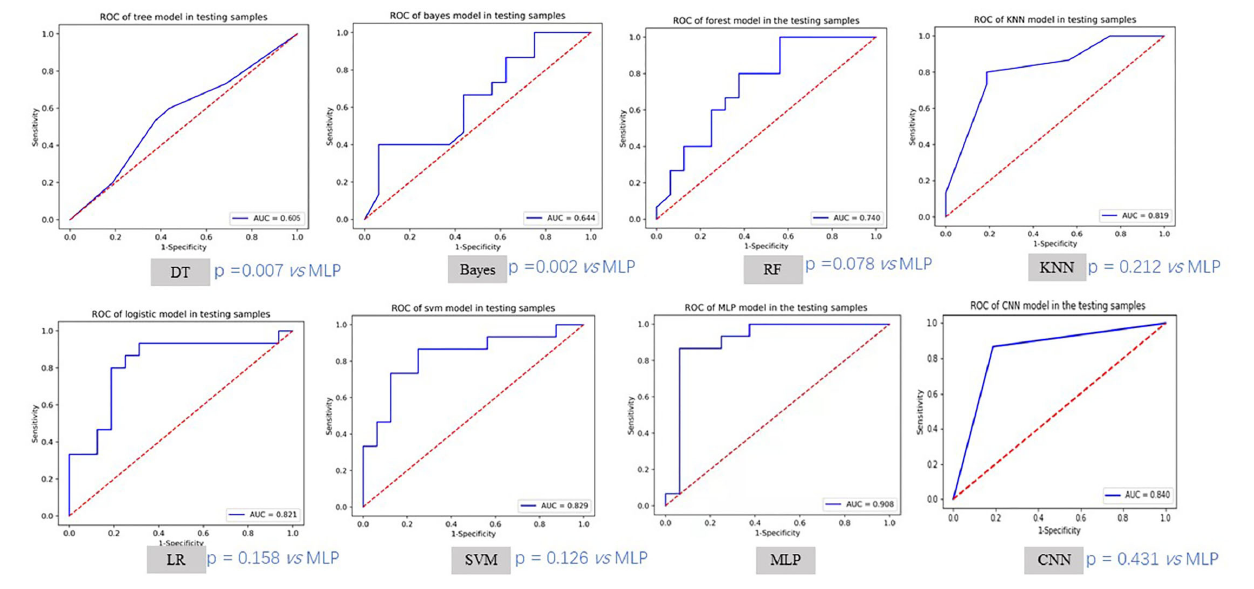
in identifying the two brain tumors with the gross visual. The studies reported that even using high-resolution MR sequences, visual differentiation of the two tumors was still challenging